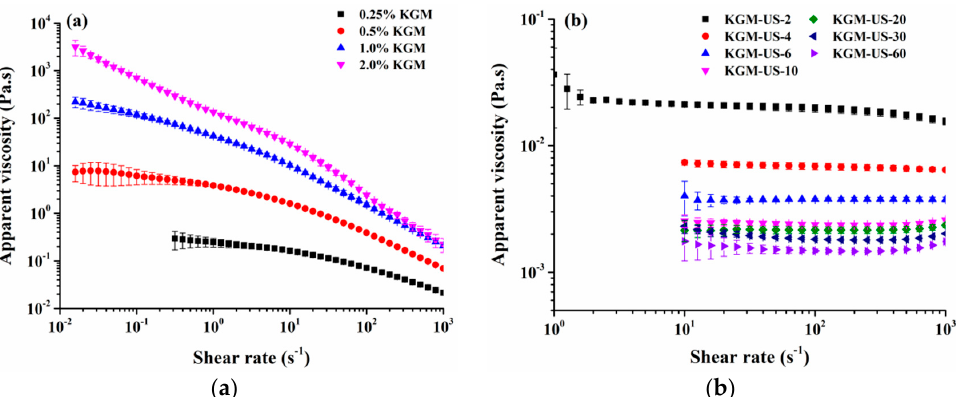
Figure 3. Apparent viscosities of original KGM and US-treated KGM. ( a ) Apparent viscosity of KGM; ( b ) apparent viscosities of US-treated KGM (KGM-US-2, KGM-US-4, KGM-US-6, KGM-US-10, KGM-US-20, KGM-US-30, and KGM-US-60). All samples were tested three times by flow sweep in the shear rate range of 0.01–1000 s − 1 at 25 °C. All values are expressed as means ± SD ( n = 3).